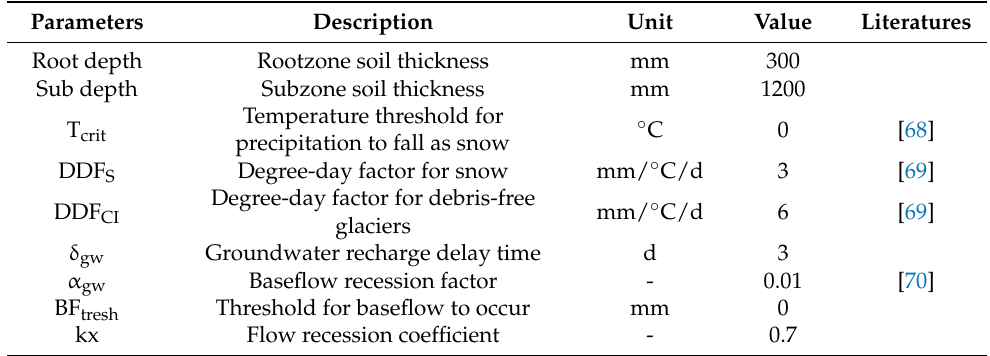
Table 2. Sensitive parameters of the SPHY model used for the simulation during the calibration period and validation